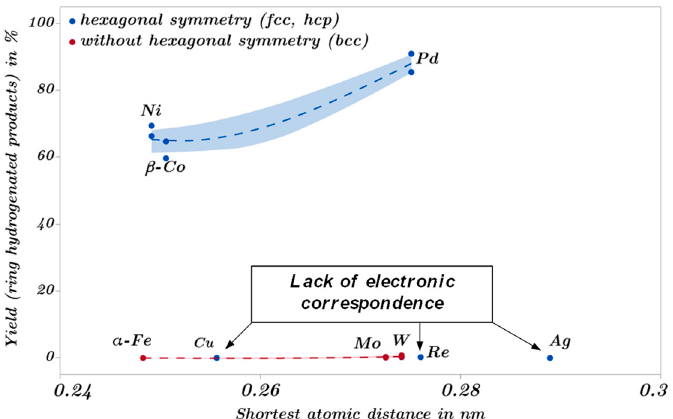
Figure 17. Dependence of the sum of the yields of the ring hydrogenated products at a reaction temperature of 250 °C as a function of the shortest atomic distance and lattice type. Hexagonal symmetry is present within the hexagonal closest packing (hcp) and the face-centered cubic lattice type (fcc), but not for the space-centered cubic (bcc).